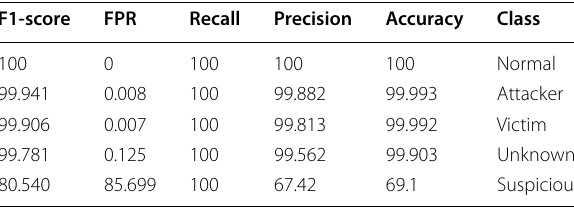
Table 1 Performance of the different classifiers in the proposed model in terms of F1-score, FRP, Recall, Precision, and